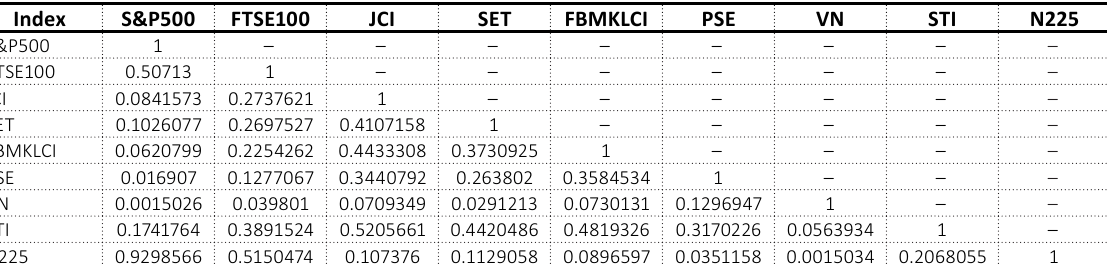
Table 8. Dynamic correlation generalized autoregressive conditional heteroskedasticity (DCC-GARCH(1,1)) estimates (maximum of